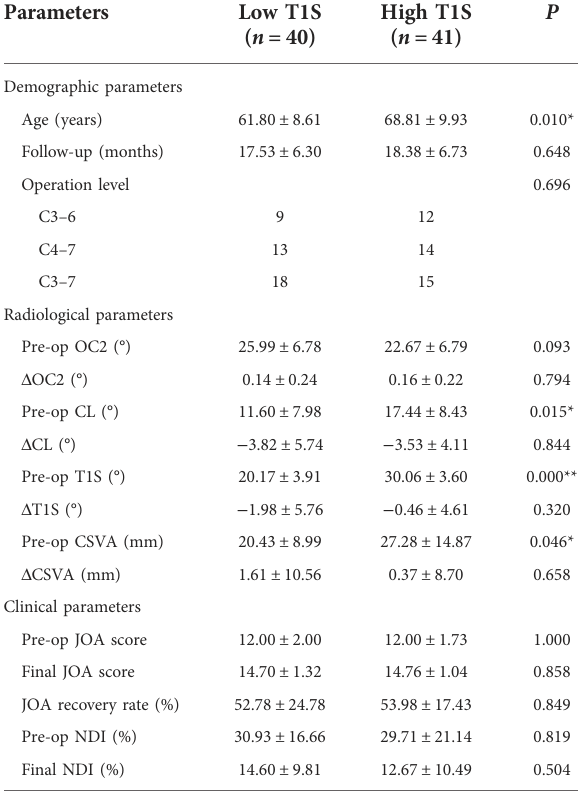
TABLE 2 Comparison of radiological parameters and clinical parameters between the low T1S group and the high T1S group. Parameters